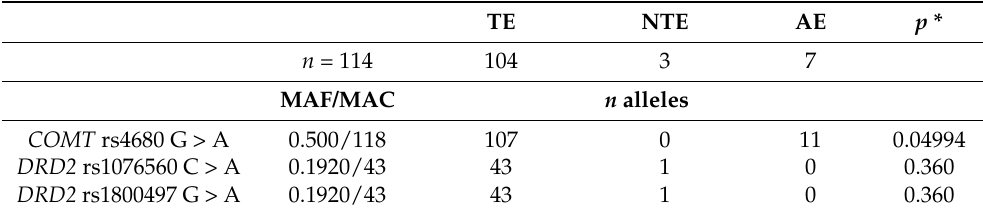
Table 7. The relationship between studied polymorphisms DRD2 rs1076560:C > A and DRD2 rs1800497:G > A and efficacy during MPH